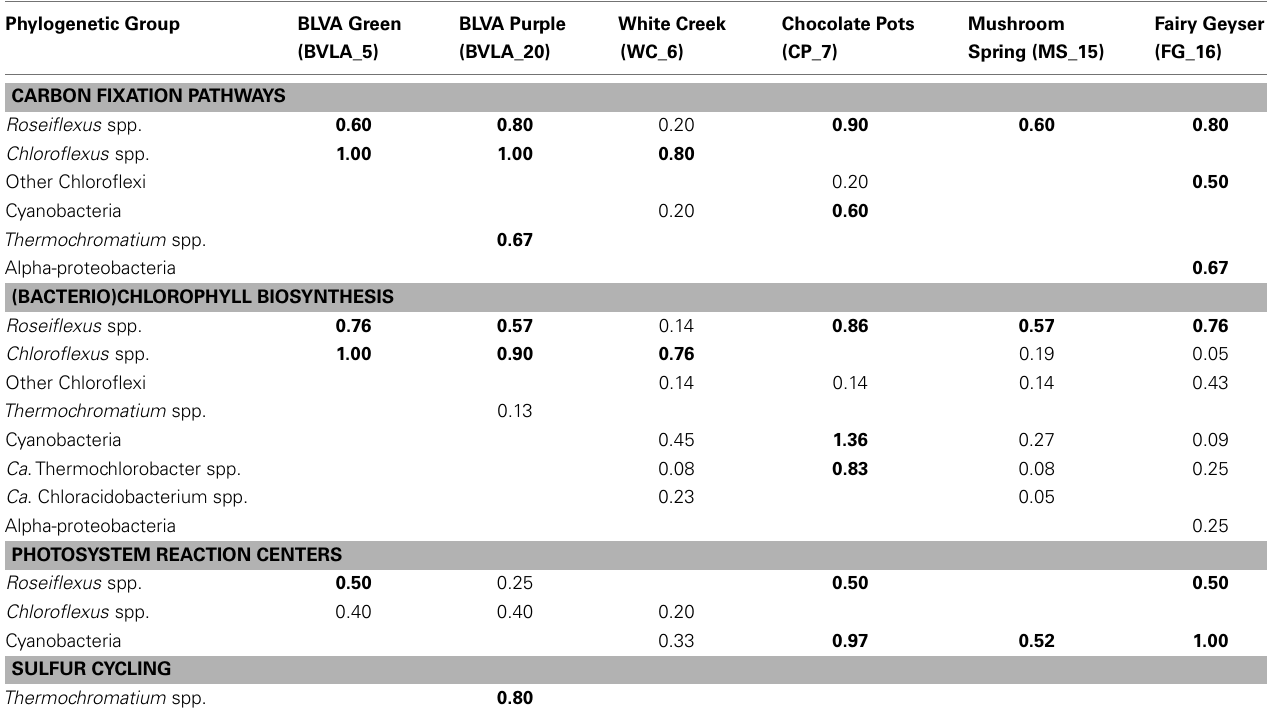
Table 3 | Phylogenetic distribution of autotrophic, phototrophic, and sulfur cycling genes in metagenomes. Phylogenetic